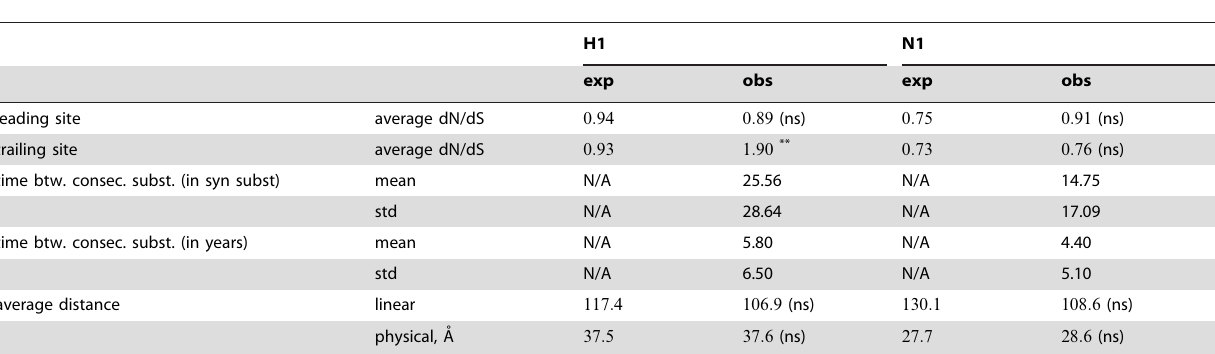
Table 3. Characterization of epistatic pairs in subtype H1N1 surface proteins, compared to expectations for randomly chosen pairs.